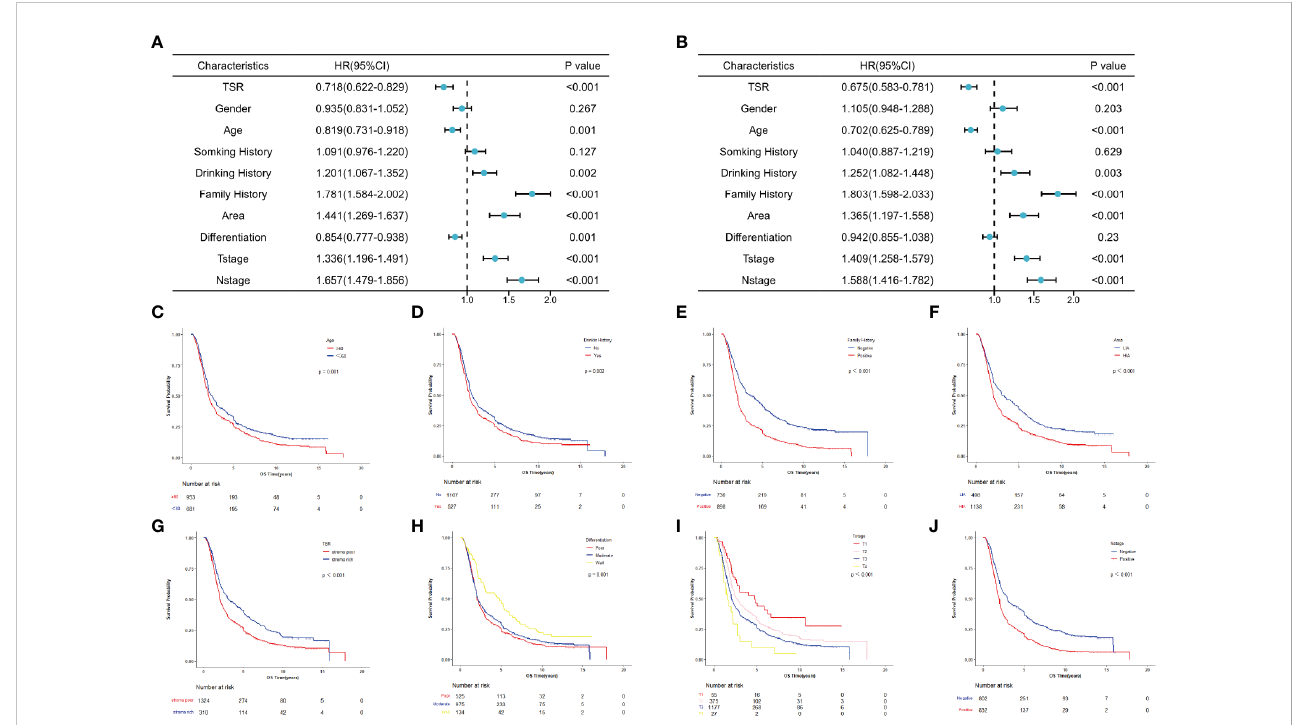
FIGURE 2 Survival analysis for patients with esophageal squamous cell carcinoma in overall populations. (A) Univariate analysis. (B) Multivariate analysis. (C – J) Survival curves for patients with age, drinking history, family history, area, TSR, differentiation, T stage and N stage, separately.